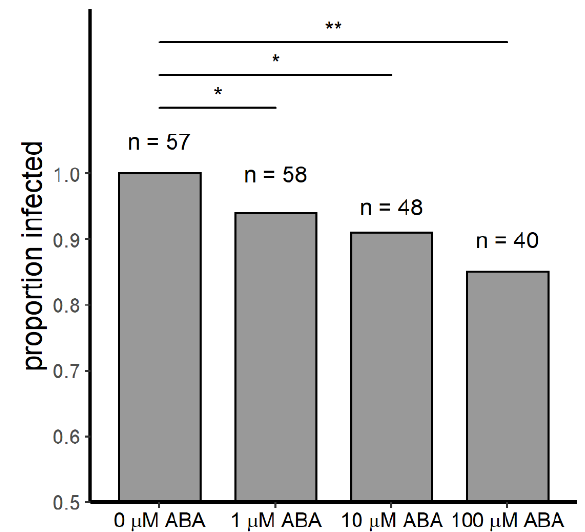
Figure 1. Proportions of female A. stephensi infected with at least one P. y. yoelii 17XNL oocyst were